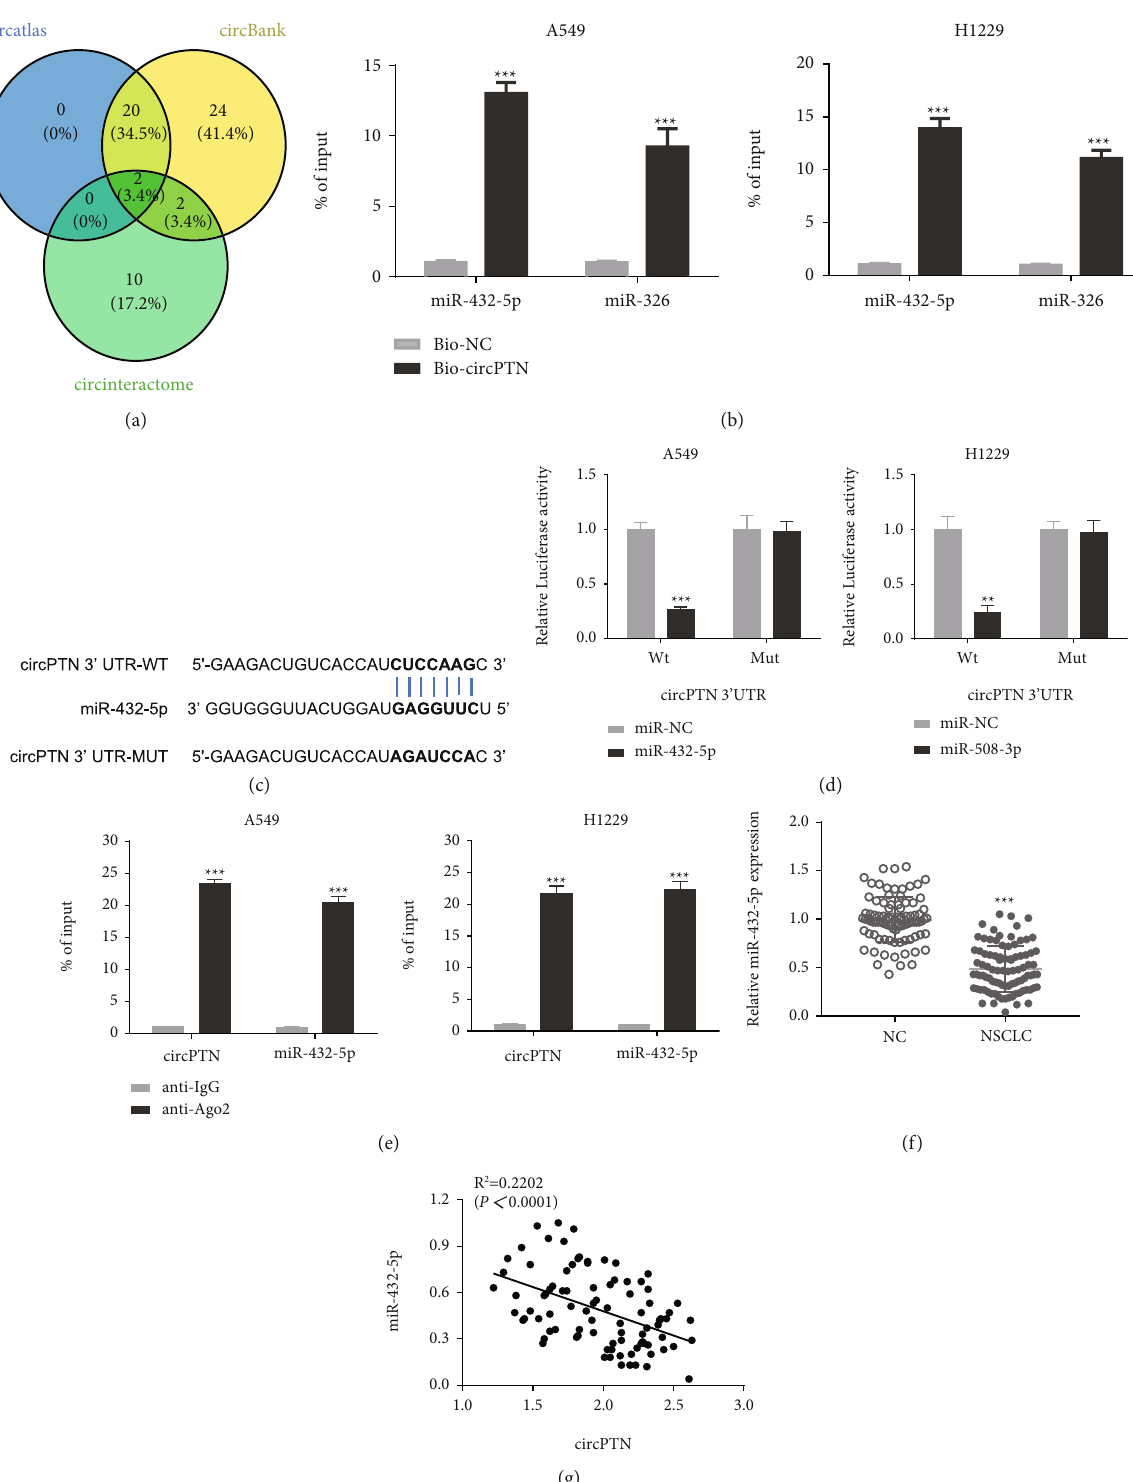
Figure 3: circPTN targets miR-432-5p. (a) Three prediction software tools were used to predict the miRNA targets of circPTN. (b) RNA- pull down assay using biotin-labeled control (Bio-NC) or circTPN probe (Bio-circTPN) in A549 and H1229 cells. The relative enrichment of miR-432-5p and miR-326 was quanti fi ed by qRT-PCR. (c) The predicted binding sites between circPTN and miR-432-5p. (d) Dual- luciferase reporter assay in A549 and H1229 cells using WT reporter (with wildtype binding sites) or MUT reporter (with mutated binding sites) in the presence of miR-NC or miR-432-5p mimic. (e) RIP-qRT-PCR assay was performed in A549 and H1229 cells using anti-Ago2 or IgG. (f) qRT-PCR was used to detect the expression of miR-432-5p in 90 pairs of NSCLC tissues and adjacent normal tissues. (g) The correlation between circPTN and miR-432-5p expression levels in NSCLC tissues. * P < 0 : 05 ; ** P < 0 : 01 ; and *** P < 0 : 001